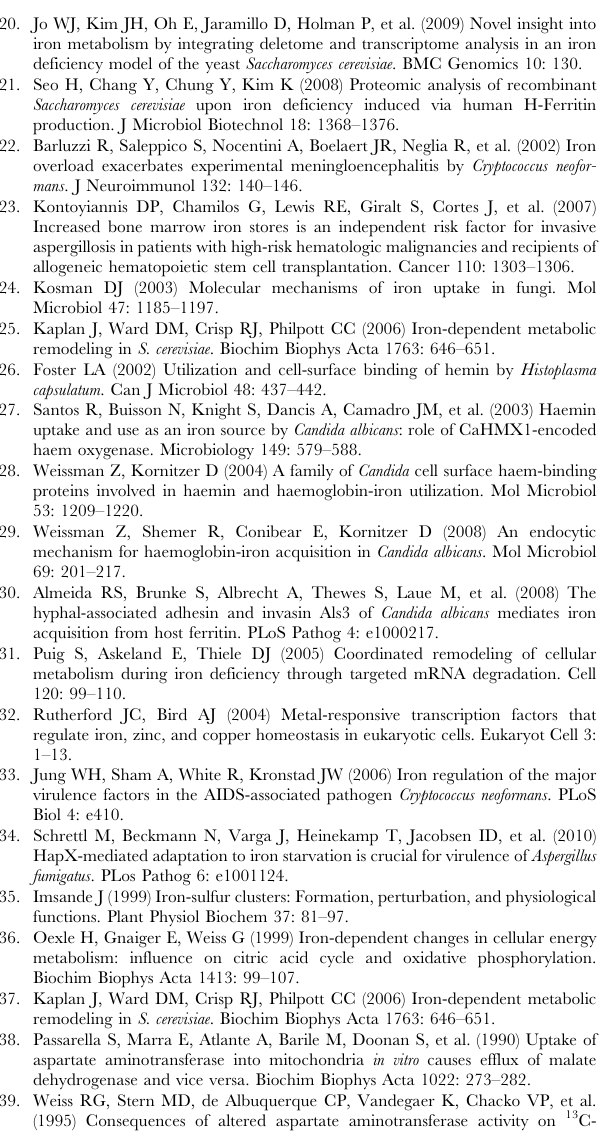
Table S3 Additional information about P. brasiliensis identified proteins with reduced expression during iron starvation. ** Spots visualized only in iron replete condition. 1 Spots numbers refers to Figure 3. 2 p values were accessed by ANOVA statistical test. Table S4 Oligonucleotide primers used in quantitative